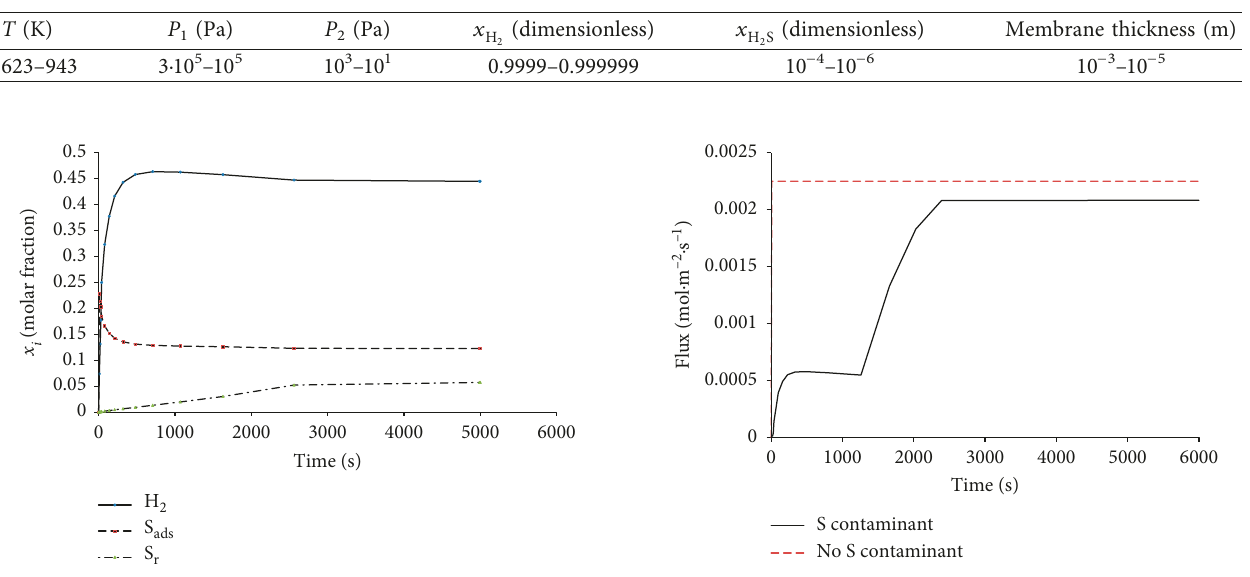
Figure 10: Time variation of hydrogen flux before and after re- moving sulfur contamination.